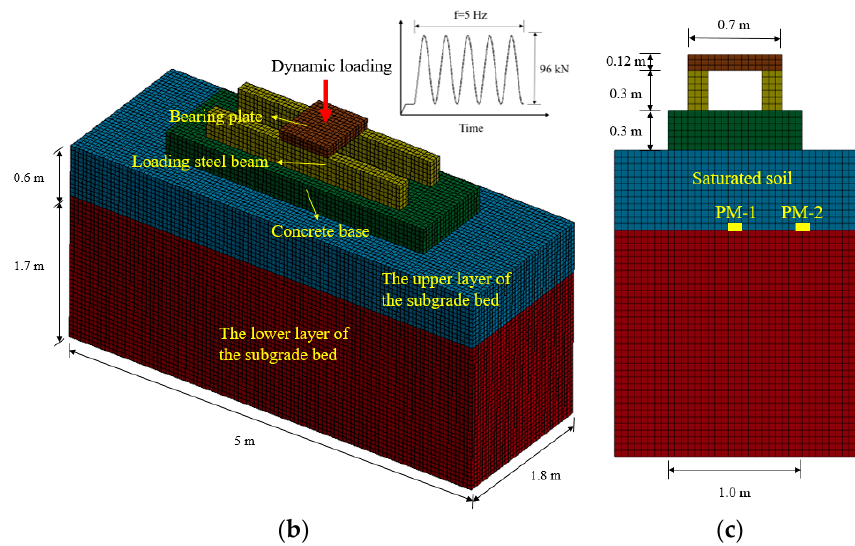
Figure 4. Lab-test model and numerical model: ( a ) Lab-test model, ( b ) numerical model developed in LS-DYNA, and ( c ) cross section of the numerical model.